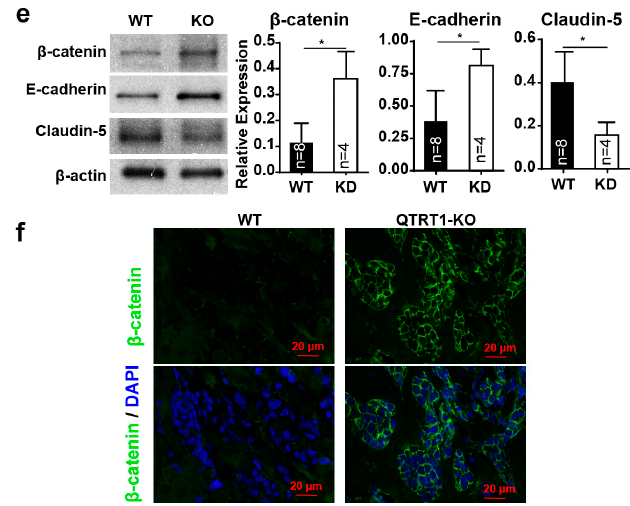
Figure 3. Knockout of QTRT1 suppressed tumor growth and altered tight junctions in tumors in vivo. ( a ) The WT and QTRT1-KO MCF7 cells were bilaterally injected into nude mice ( n = 10 mice), and tumors were harvested 60 days post injection (WT: n = 16 tumors; KO: n = 9 tumors). The representative photograph of tumors in vivo and in vitro (left), tumor volume, and tumor weight were shown. The scale bar indicates 10 mm. Each circle represents an individual tumor. Mean ± SD, n = 16 or n = 9; ** p -value < 0.01, *** p -value < 0.001, two-tailed Welch’s t -test. ( b ) BrdU immunofluorescence staining and index analysis were performed on the tumors from nude mice injected with WT and QTRT1-KO MCF7 cells. BrdU was detected with sheep monoclonal anti-BrdU and anti-sheep Alexa Fluor 594 [20] antibody. The scale bar is 20 µm. Mean ± SD, n = 8 or n = 4; ** p -value < 0.01, two-tailed Welch’s t -test. ( c ) Immunocytochemical analysis of PCNA in tumors from nude mice. PCNA and DNA were stained with mouse monoclonal anti-PCNA and anti-mouse Alexa Fluor 488 antibody, and DAPI, respectively. The scale bar is 20 µm. ( d ) Western blot analysis of PCNA in tumors harvested from the mice injected with WT and QTRT1-KO MCF7 cells. The graph shows the band intensities of PCNA proteins. Mean ± SD n = 8 or n = 4; * p -value < 0.05, two-tailed Welch’s t -test. ( e ) Western blot analysis of tight junction regulators was performed on the tumors isolated from the nude mice model injected with WT and QTRT1-KO MCF7 breast cancer cells. The graphs show the relative expression of the target proteins detected by Western blot. Mean ± SD, n = 8 or n = 4; * p -value < 0.05, two-tailed Welch’s t -test. ( f ) Immunofluorescence staining of β -catenin was performed on tumors from both QTRT1-KO-injected mice and WT-injected mice. Proteins and DNA were stained with mouse monoclonal anti- β -catenin and anti-mouse Alexa Fluor 488 antibody and DAPI, respectively. Scale bar is 20 µ